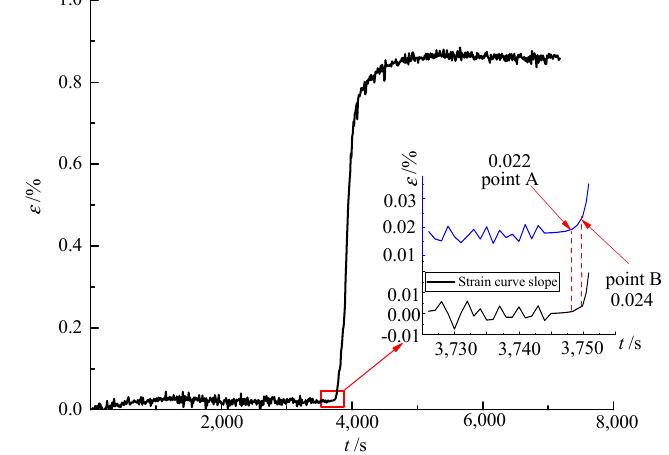
Figure 12. The generalized strain evolution curve of the frost-heave crack propagation of specimen A1.